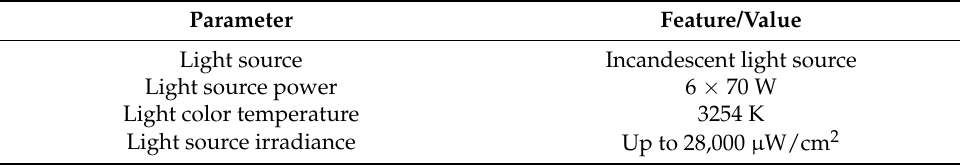
Table 5. Summary of the light source